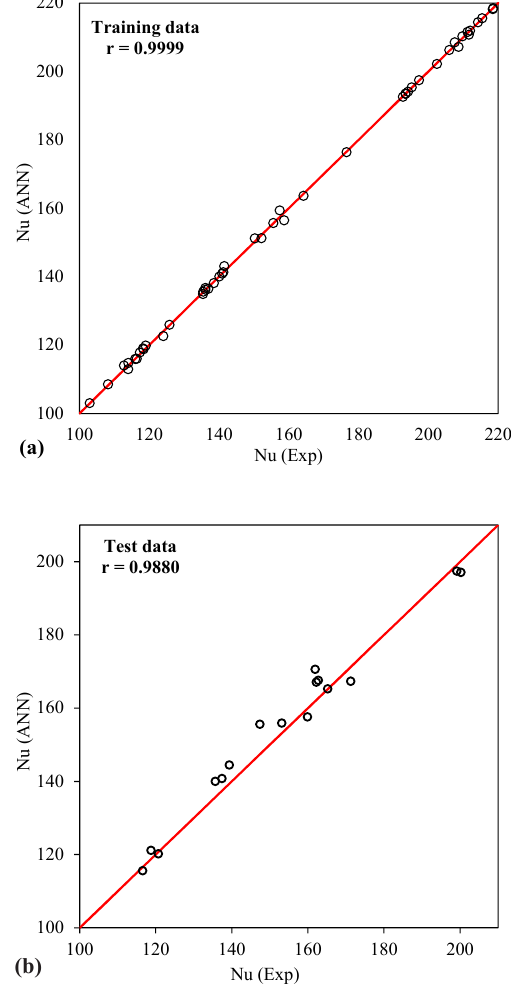
Fig. 4. ANN predicted Nu against experimental Nu in (a) training dataset and (b) test dataset.